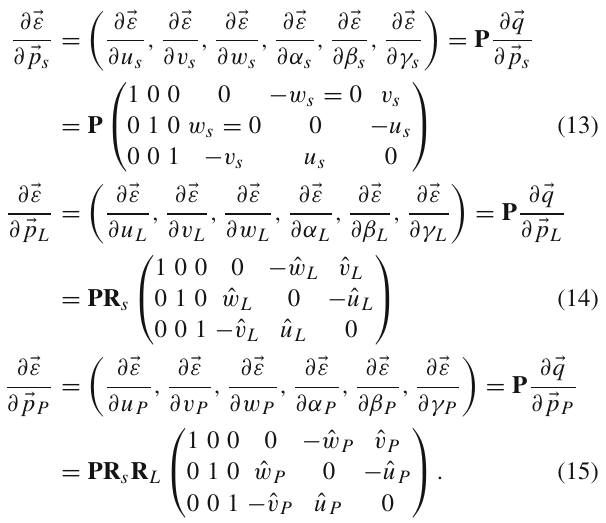
Fig. 4 Schematics of a a ladder and b a layer divided into fine uniform grids